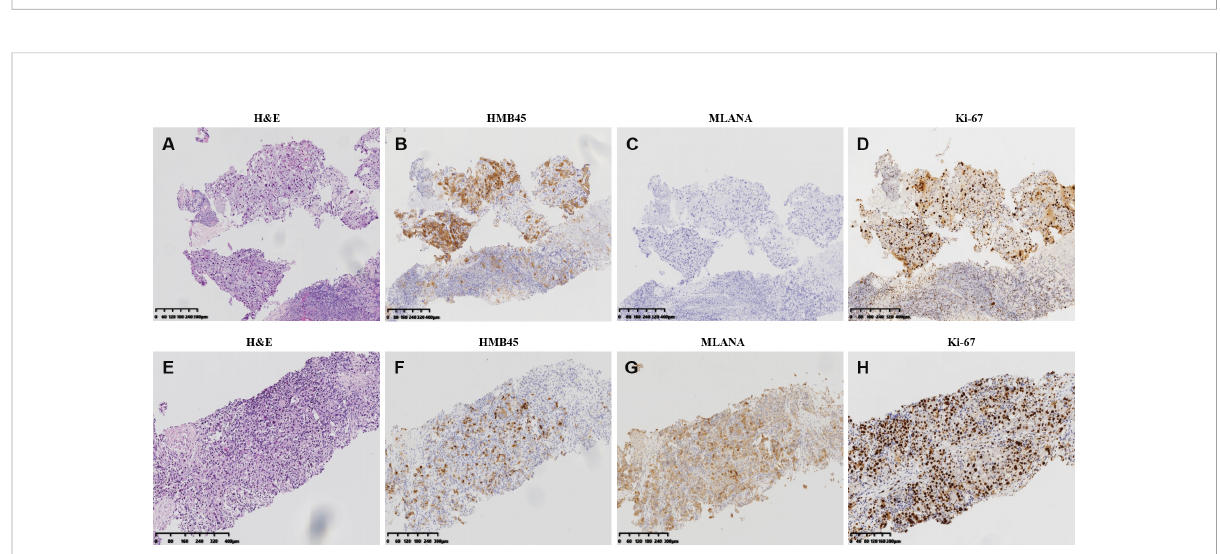
FIGURE 3 Pathological and immunohistochemistry features of the perivascular epithelioid cell tumor metastases. (A – D) hematoxylin – eosin staining (A) and imunohistochemistry of HMB45 (B) , MLANA (C) , and Ki-67 (D) of the biopsy specimen of the pelvis metastases identi fi ed 10 months after the resection of the primary tumor. (E-H) hematoxylin – eosin staining (E) and imunohistochemistry of HMB45 (F) , MLANA (G) , and Ki-67 (H) of the biopsy specimen of the gallbladder fossa metastases identi fi ed 15 months after pelvis manifestation and the initiation of anti-VEGFR TKI